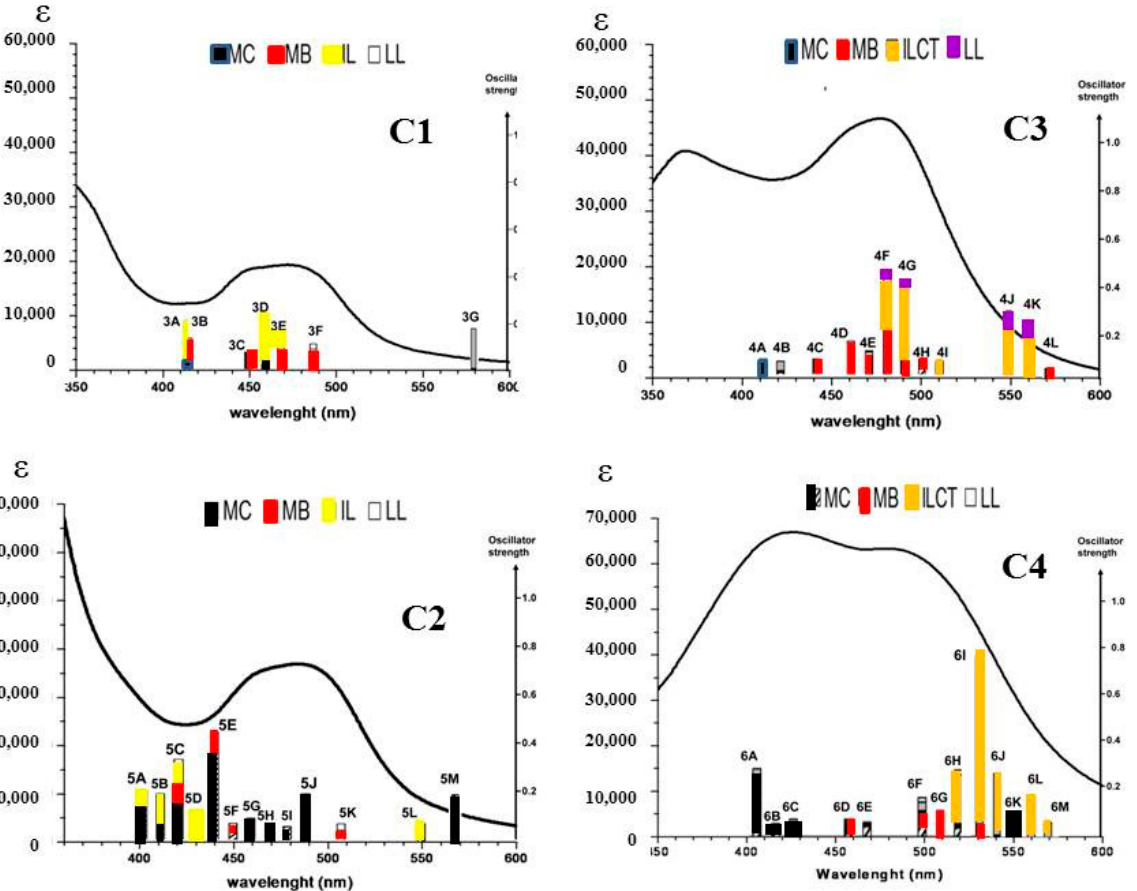
Figure 10. Experimental absorption spectra and calculated electronic transitions(bar) showing the participation of basic electronic excitations, MC, MB, IL, ILCT and LL.